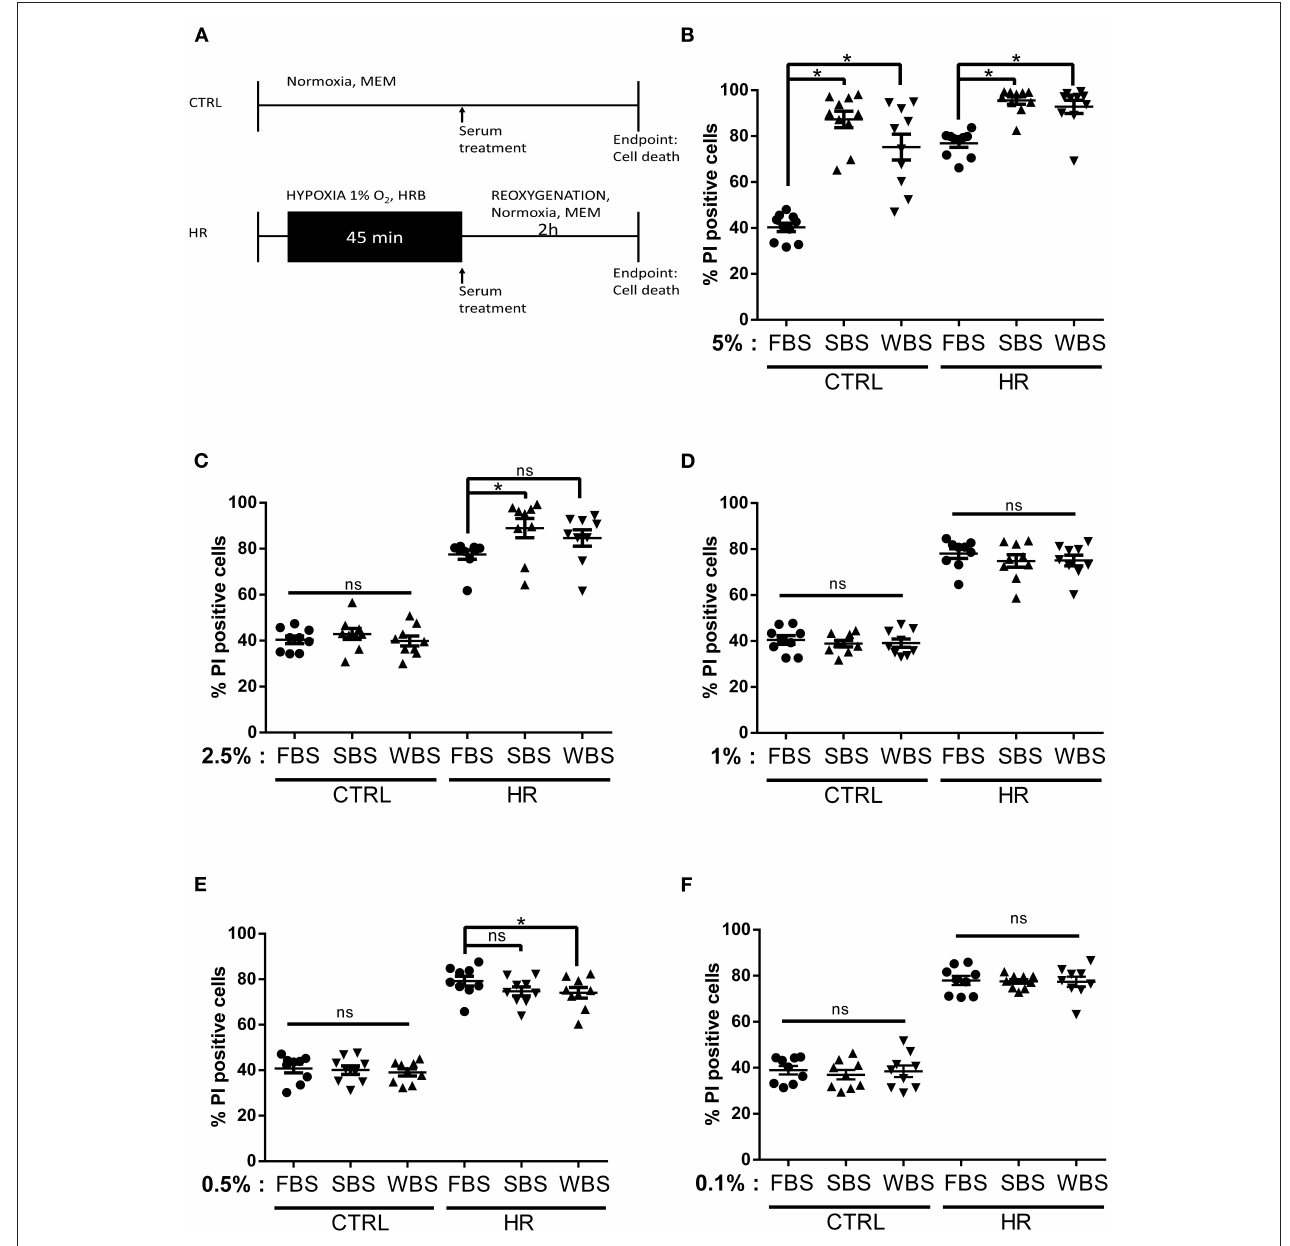
FIGURE 1 | Dose–response effects of bear serum treatment on cardiomyocyte viability: (A) Experimental design. Isolated mouse cardiomyocytes underwent 45-min hypoxia followed by 2-h reoxygenation. At the onset of reoxygenation, normoxic and hypoxic cardiomyocytes received serum concentrations as indicated. The percentage of cell death was measured in both normoxic (CTRL) and hypoxic (HR) cells treated with (B) 5%, (C) 2.5%, (D) 1%, (E) 0.5%, and (F) 0.1% of fetal bovine serum (FBS), summer bear serum (SBS), and winter bear serum (WBS). Mean of propidium iodide (PI) positive cells ± SD, n = 9–10 different experimental days with 1,000 events/assay (* p < 0.05). Differences in means among multiple groups were analyzed using two-way ANOVA with a Tukey’s post-hoc test (ns: non